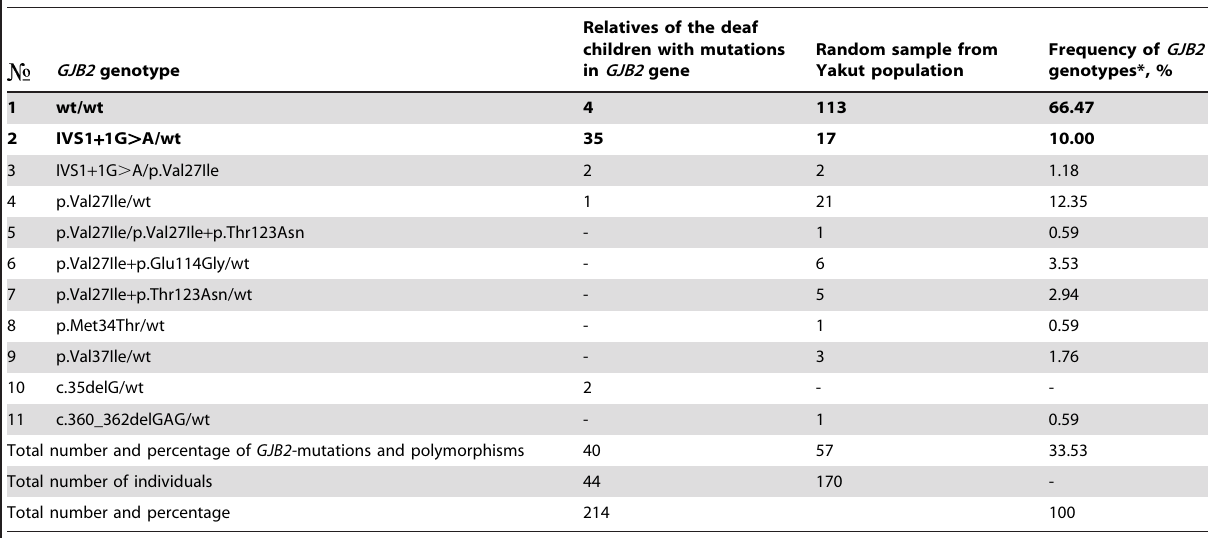
Table 1. Mutation analysis of GJB2 gene.